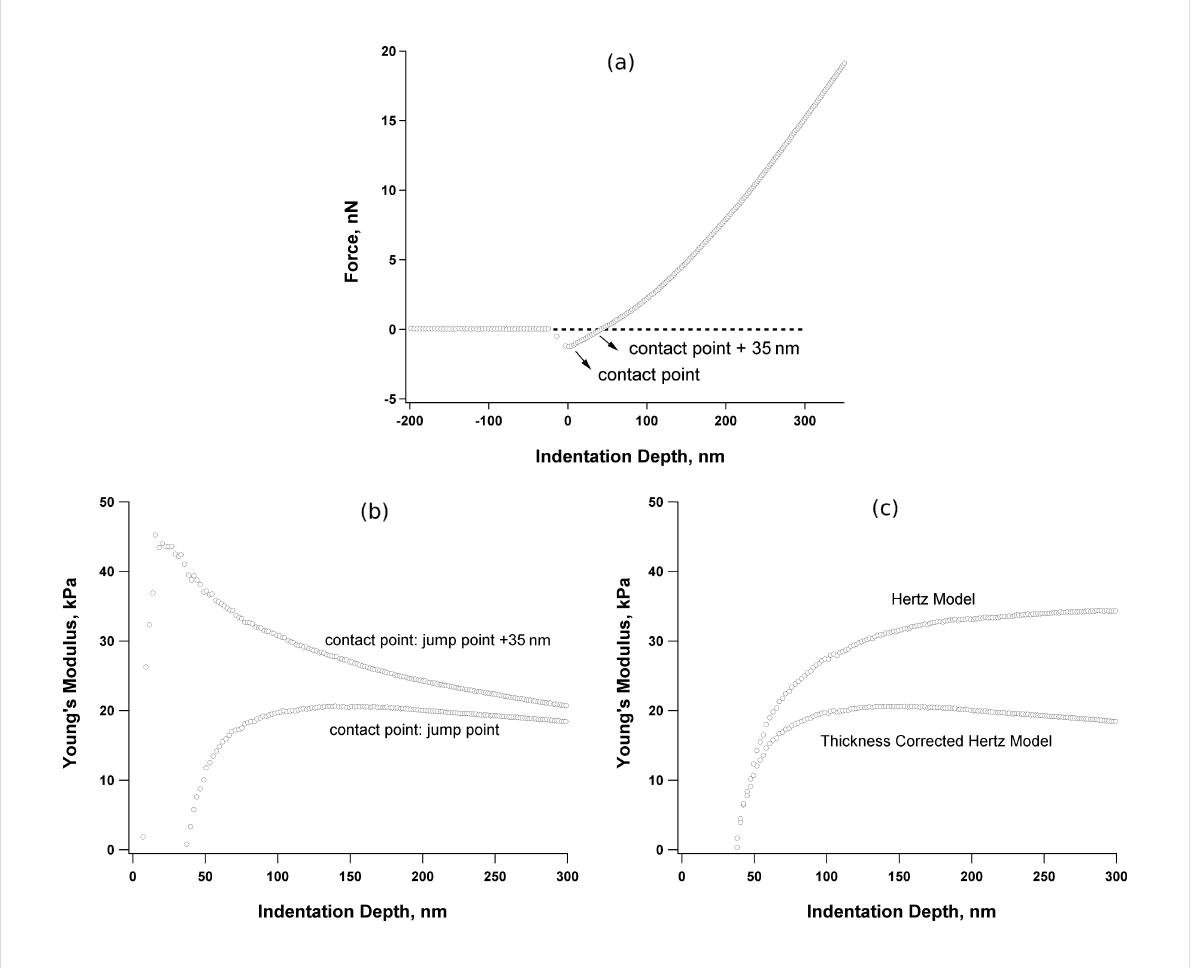
Figure 4: (a) A typical force–indentation depth curve as measured by CP-AFM on (PLL/HA) 24 . The jump point of the colloidal-probe to the film surface was taken as the contact point. (b) Young’s modulus versus indentation depth for two contact-point choices and (c) Young’s modulus calculated with the classical [36] and thickness-corrected [37] Hertzian